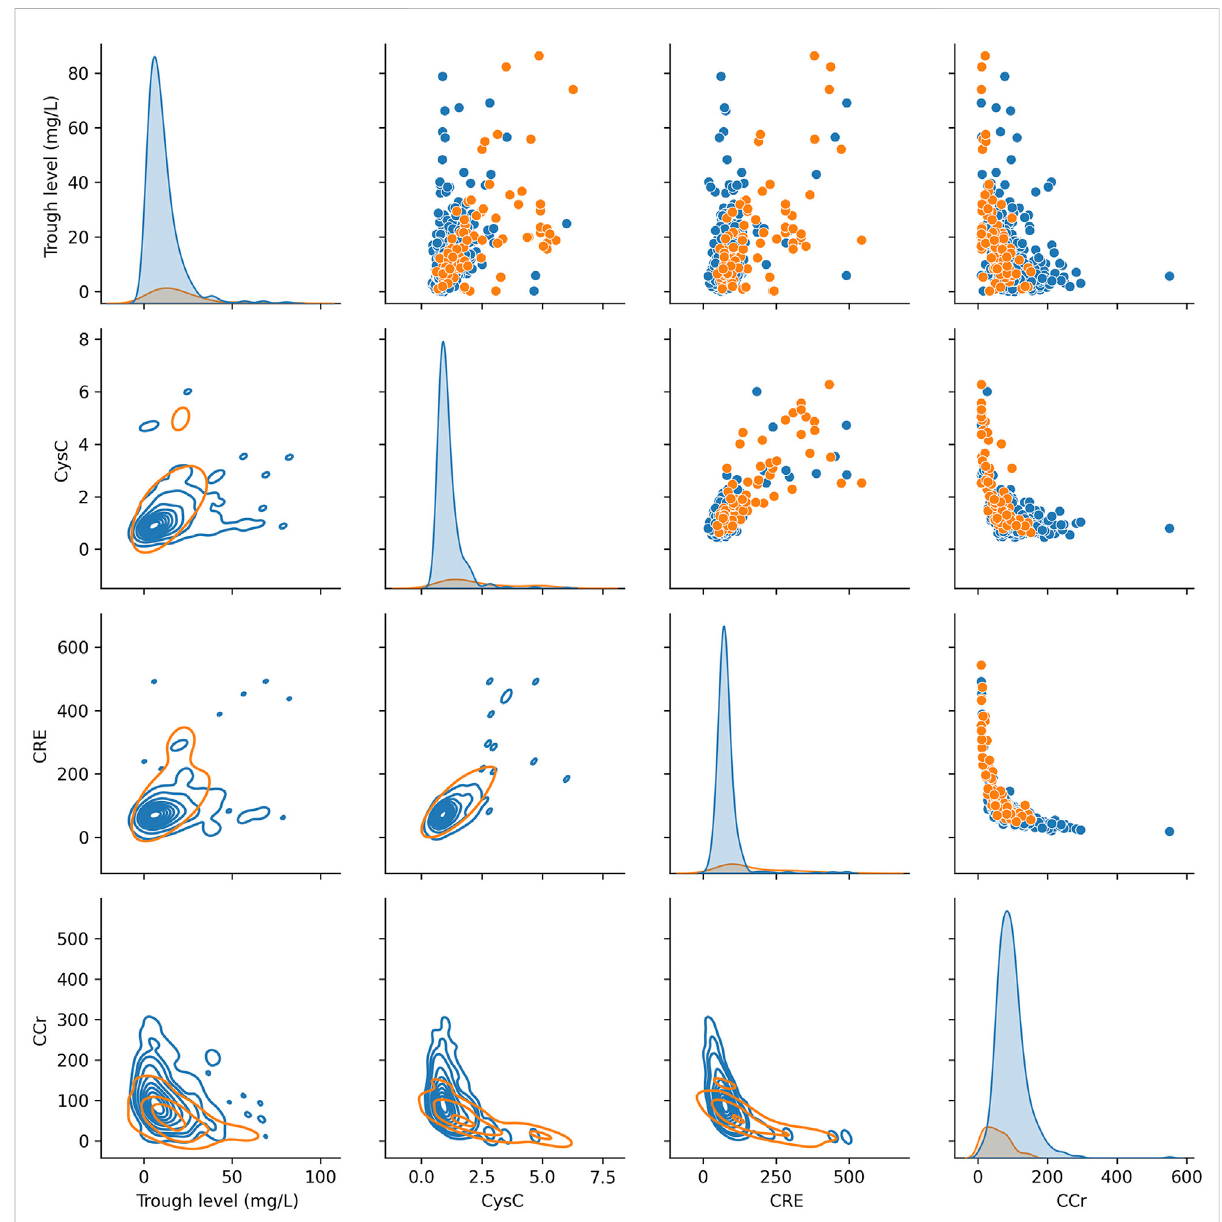
FIGURE 2 KDEplots ofkeyindicatorsfor vancomycin-associated AKI(onthediagonal).Scatterplotanalysis(above thediagonal). KDEplotsofconditional distributions with 2D Gaussian (under the